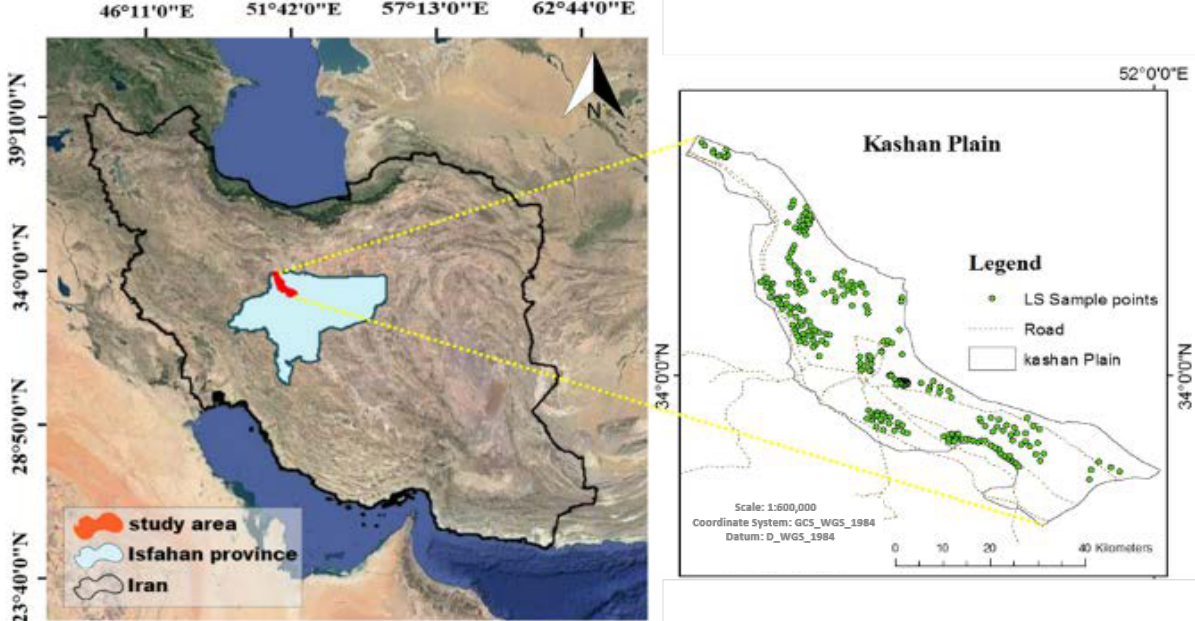
Figure 1. Study area and location of the employed LS sample